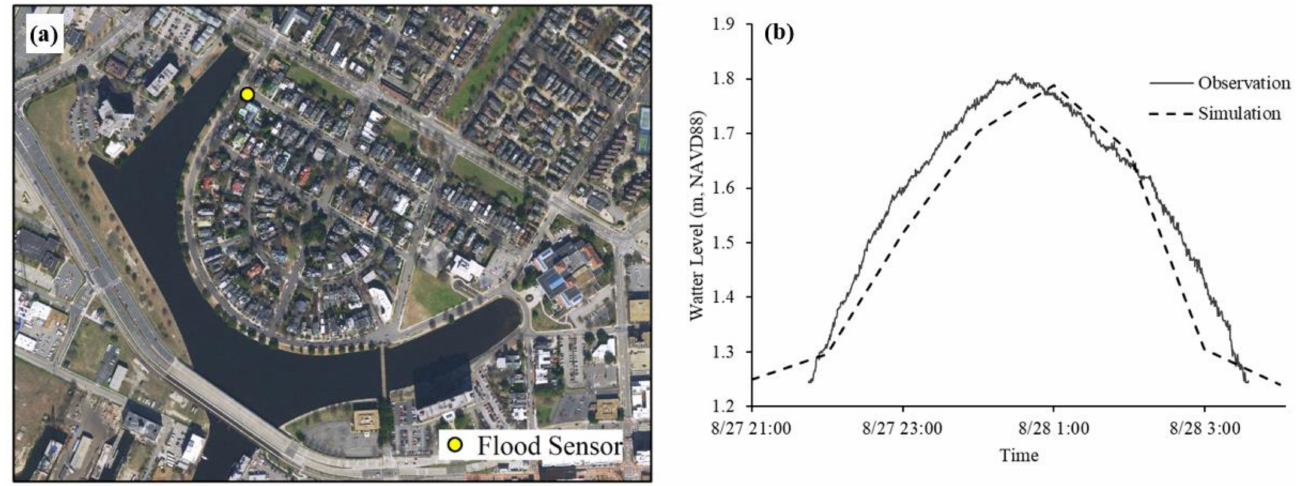
Figure 7. Evaluating the coupled flood model with a temporary USGS gauge deployed during Hurricane Irene (2011). ( a ) Location of the USGS gauge; ( b ) Comparison between observed and simulated water